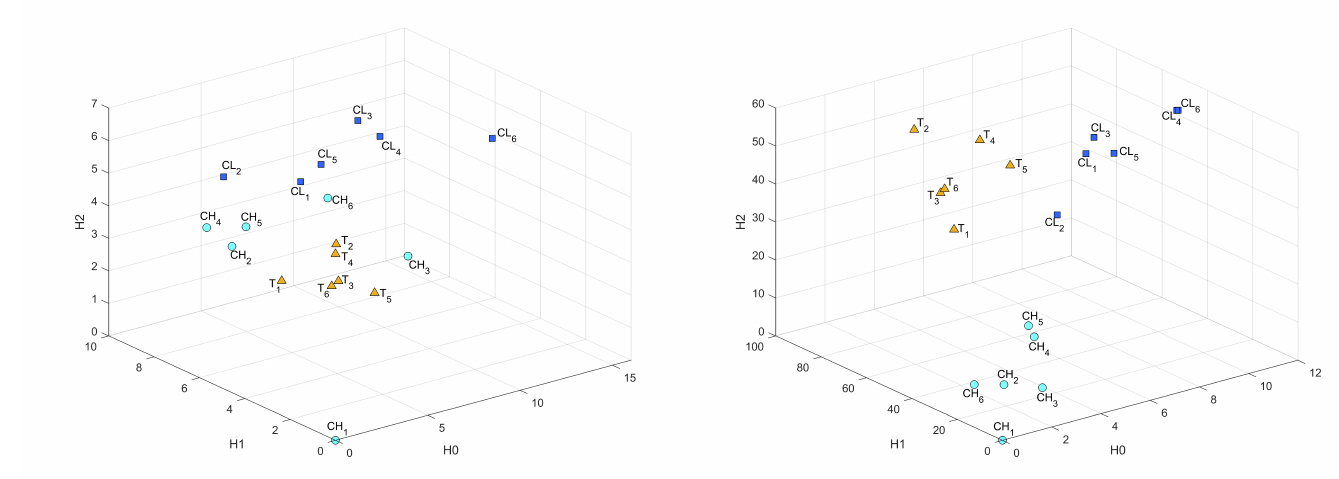
Figure A2. Comparison of 2 classes of C ( CH, CL ) samples with T samples ( T ) in Bottleneck and Heat Kernel metrics in 3D coordinates.